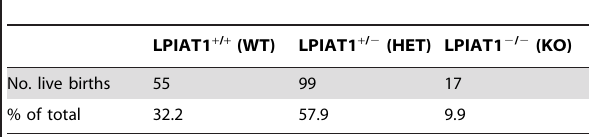
Table 1. Numbers of genotypes in litters from LPIAT1 + / 2